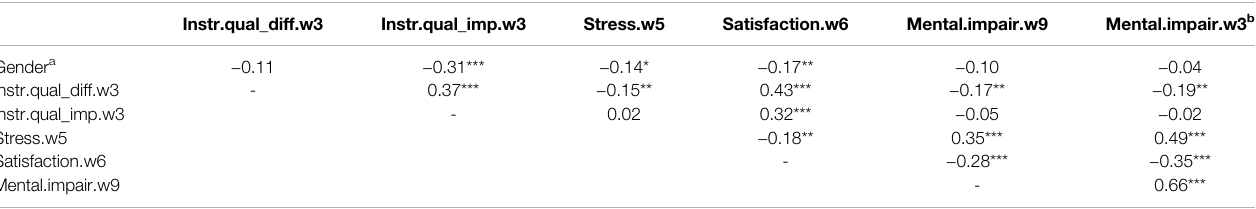
TABLE 3 | Intercorrelation among analyzed constructs ( n (cid:1) 209). Instr.qual_diff.w3